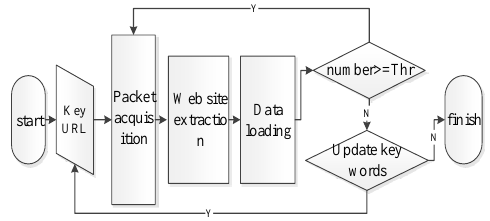
Figure 4. The flowchart of crawling the images of the Moon Gate before collapse